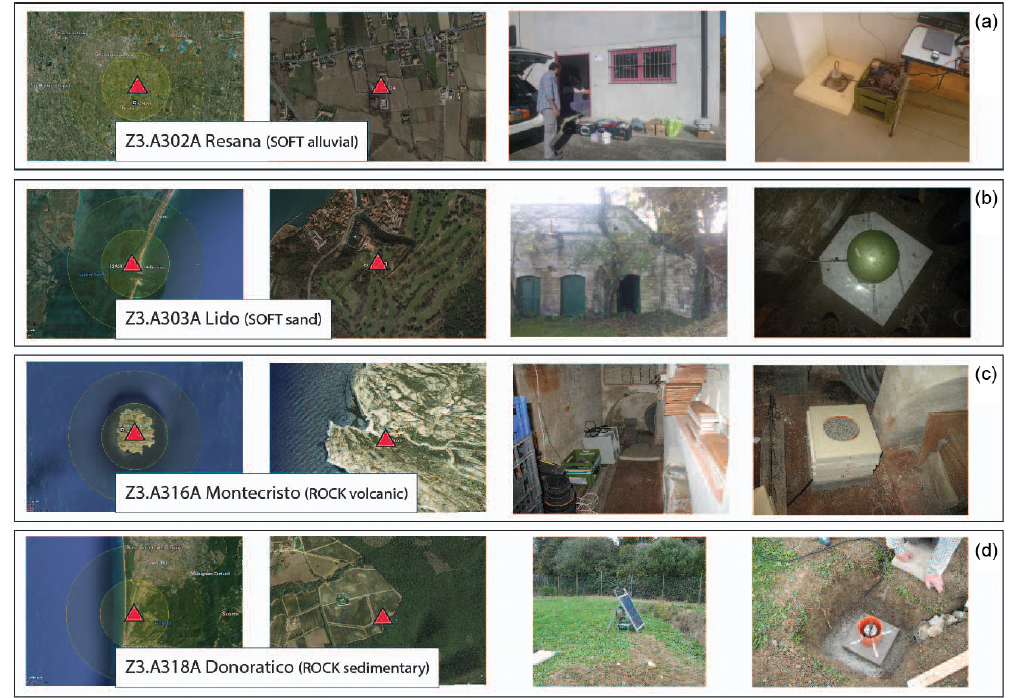
Figure 2. Examples of installations for four representative soil types (rows). The station position (red triangles) is indicated on distant (first column) and closer (second column) views extracted from Google Earth. Pictures from each installation are shown in the third and fourth columns. The stations are: (a) Z3.A302A, Resana (Treviso, Veneto); (b) Z3.A303A, Lido di Venezia (Veneto); (c) Z3.A316A, Montecristo Island (Livorno, Tuscany); (d) Z3.A318A, Donoratico (Livorno,